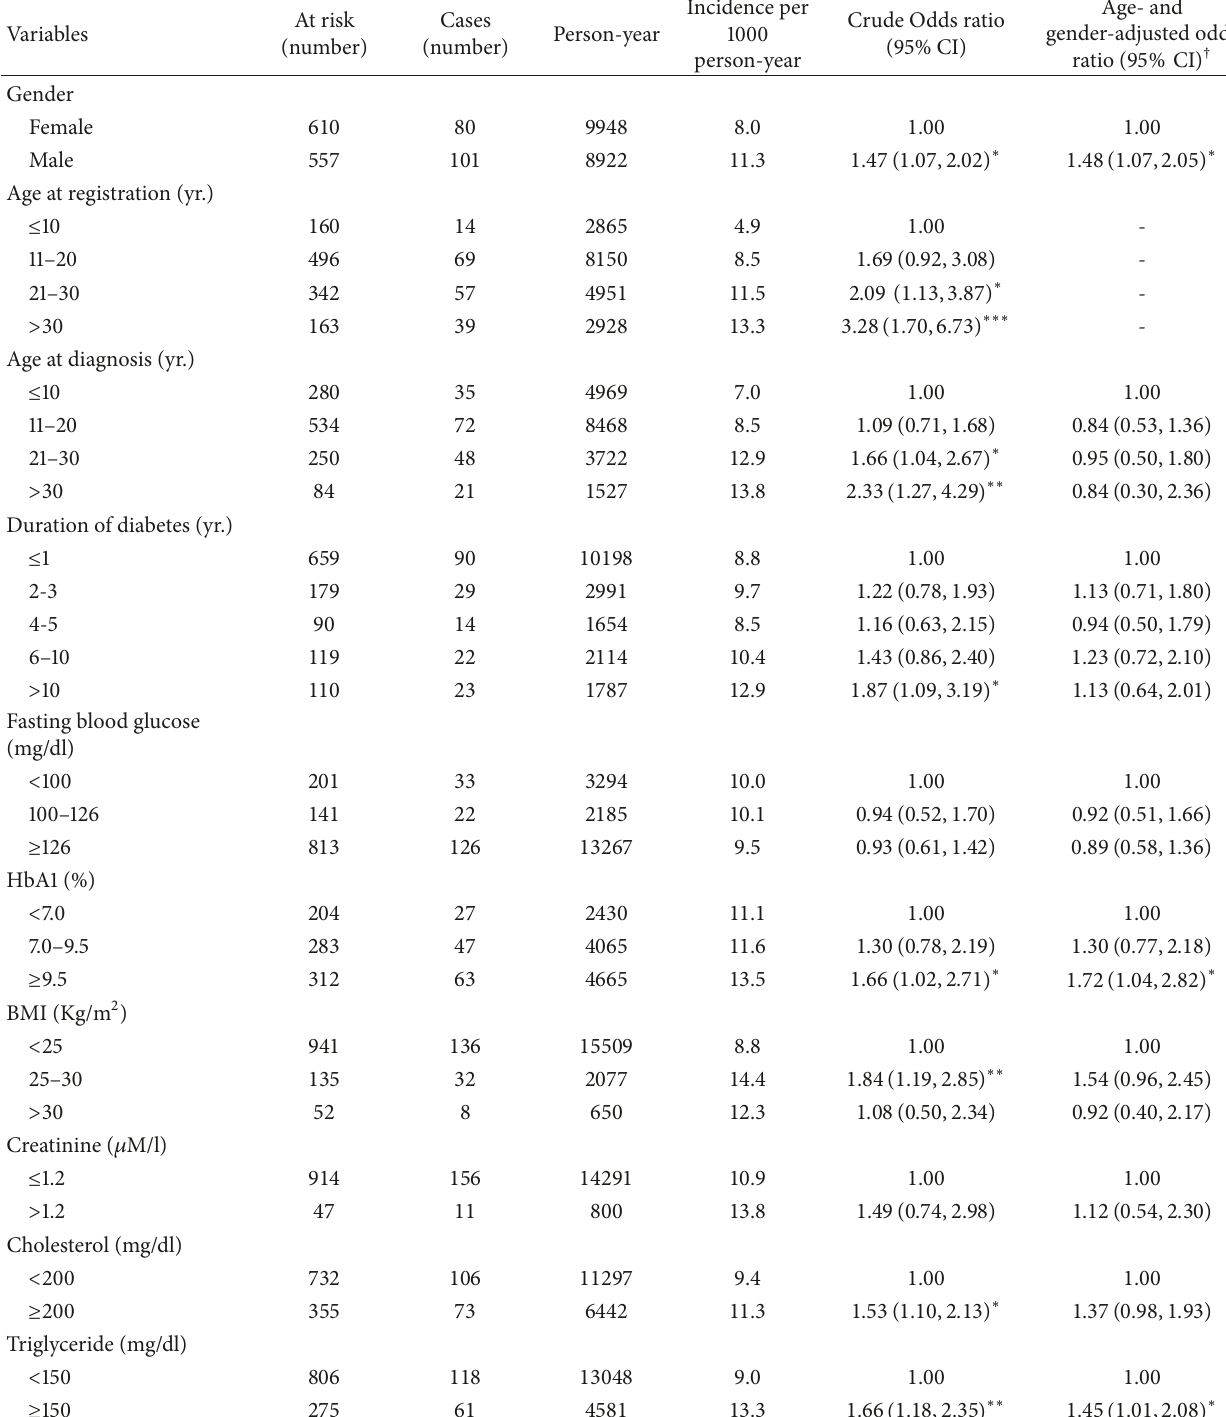
Table 2: Incidence rates of hypertension by baseline